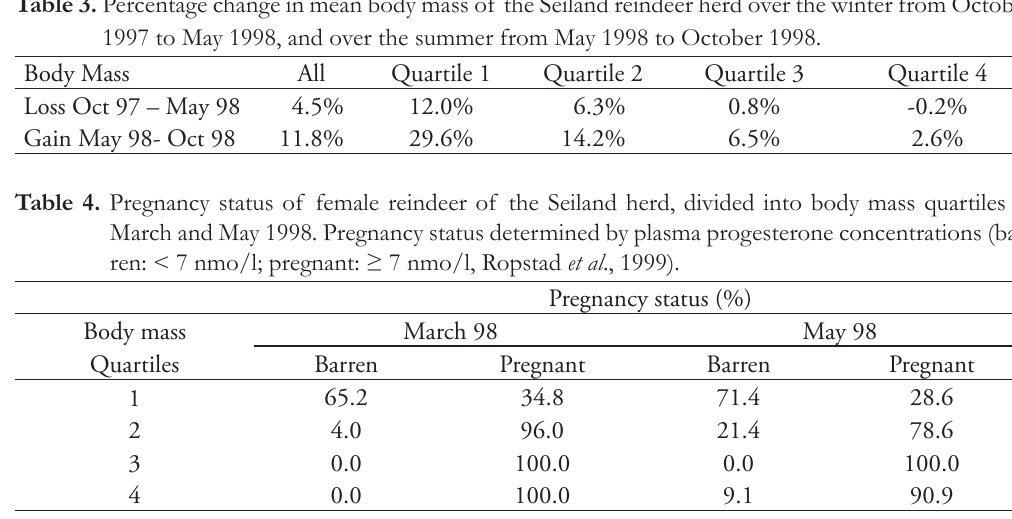
Productivity (kg/live reindeer) Data from the Norwegian Reindeer Husbandry Administration. Table 3. Percentage change in mean body mass of the Seiland reindeer herd over the winter from October 1997 to May 1998, and over the summer from May 1998 to October 1998.